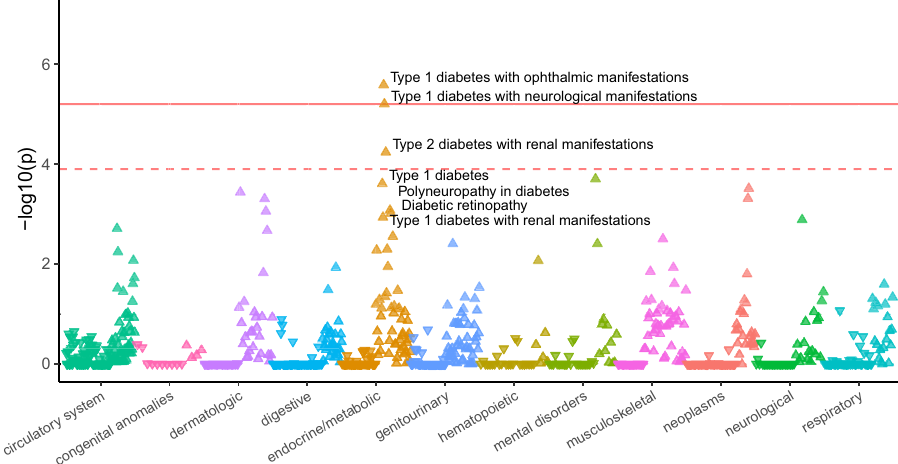
Fig. 4 Phenome-wide association study (PheWAS) of predicted stop-strengthening variant in a translated uORF in PMVK. PheWAS plot of translated uORF stop-strengthening variant in the 5 ′ UTR of PMVK ( N = 65 carriers) in the Penn Medicine BioBank. ICD-9 and ICD-10 Phecodes are organized and plotted by category on the X-axis. Each point represents a single Phecode. The height of each point corresponds to the − log 10 ( P value) of the association between the variant and Phecode using a logistic regression model adjusted for age, age 2 , sex, and the fi rst ten principal components (PCs) of genetic ancestry. The solid red line represents the threshold for Bonferroni-adjusted signi fi cance ( P = 6.25e – 6) and the red dashed line represents the FDR < 0.10 threshold ( P = 1.25e-4) accounting for multiple comparisons. The direction of each arrowhead corresponds to increased risk (up) or decreased risk